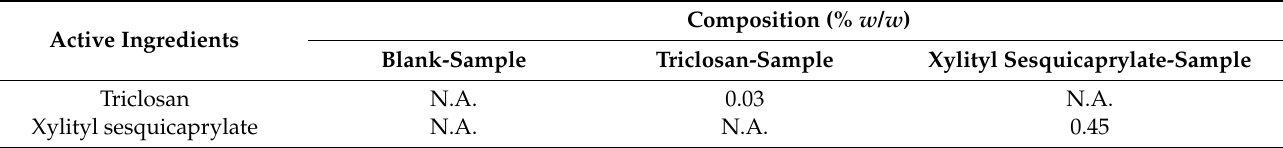
Table 2. Active ingredients (% w / w ) of the mouthwash samples (blank, containing triclosan or xylityl sesquicaprilate)